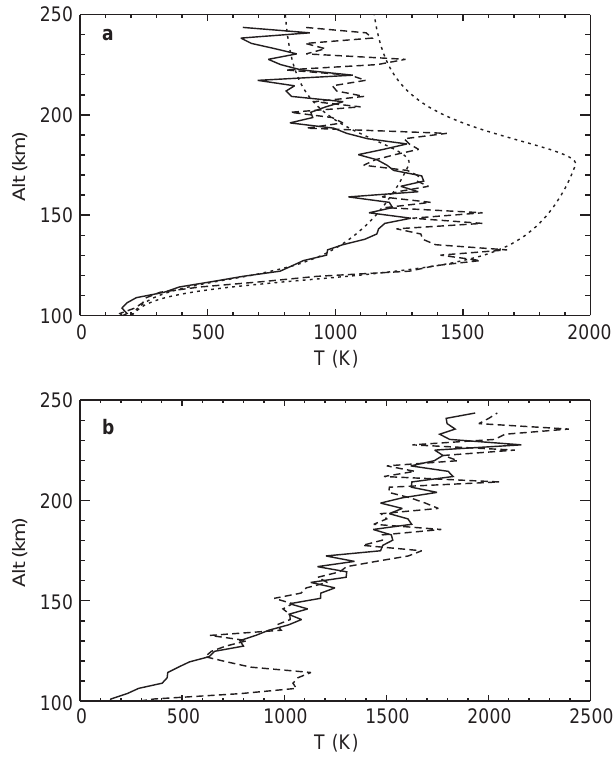
Fig. 6. Average electron ( bottom panel , b ) and average parallel ion ( top panel , a ) temperature profiles from the multipulse data when the long pulse parallel ion temperature at 168 km was between 1365 K and 1425 K. The UTEB values are given by the dash lines and the ordinary average values by the full lines . The dotted lines in a are model values computed using a 775 m/s ion drift for the smaller values and using a 1200 m/s ion drift for the larger values. The model neutral background density value was reduced to 80% of its